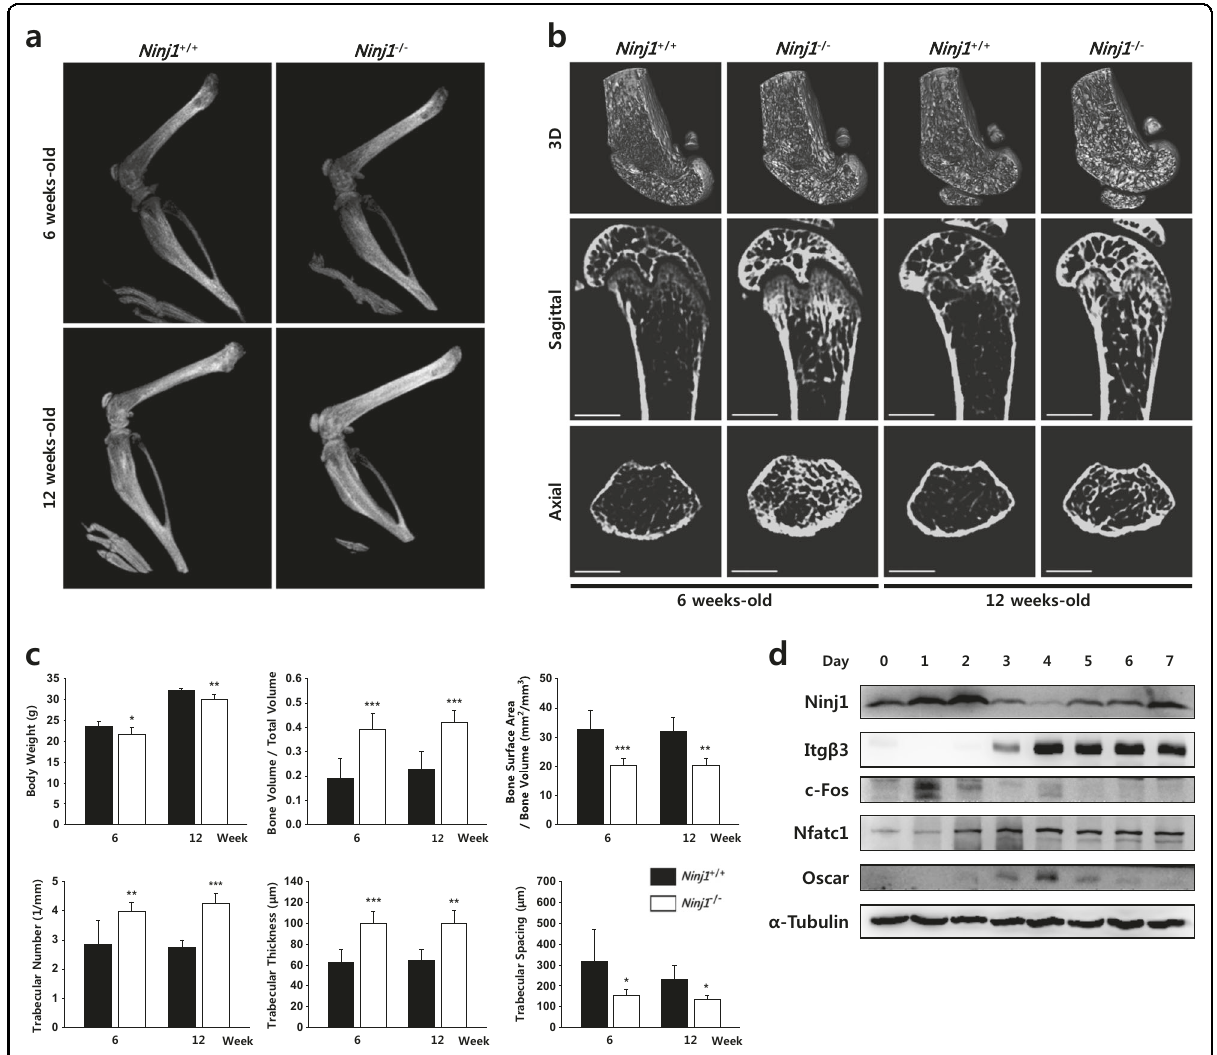
Fig. 1 Ninj1 − / − mice show mild osteopetrosis, and Ninj1 is expressed in osteoclasts. a Representative plain X-ray images of hind limbs from Ninj1 − / − 6- or 12-week-old mice and their corresponding WT littermate mice. b Representative μ CT images of distal femurs from Ninj1 − / − 6- or 12- week-old mice and their corresponding WT littermate mice. Scale bars, 1 mm. c μ CT-determined trabecular bone parameters of distal femurs from 6- or 12-week-old WT ( n = 5, and n = 4, respectively) and Ninj1 − / − mice (6-week-old; n = 7, 12-week-old; n = 6). d Ninj1 expression during osteoclast development. Quantitative data are shown as the mean ± SD, * P < 0.05, ** P < 0.01, and *** P <